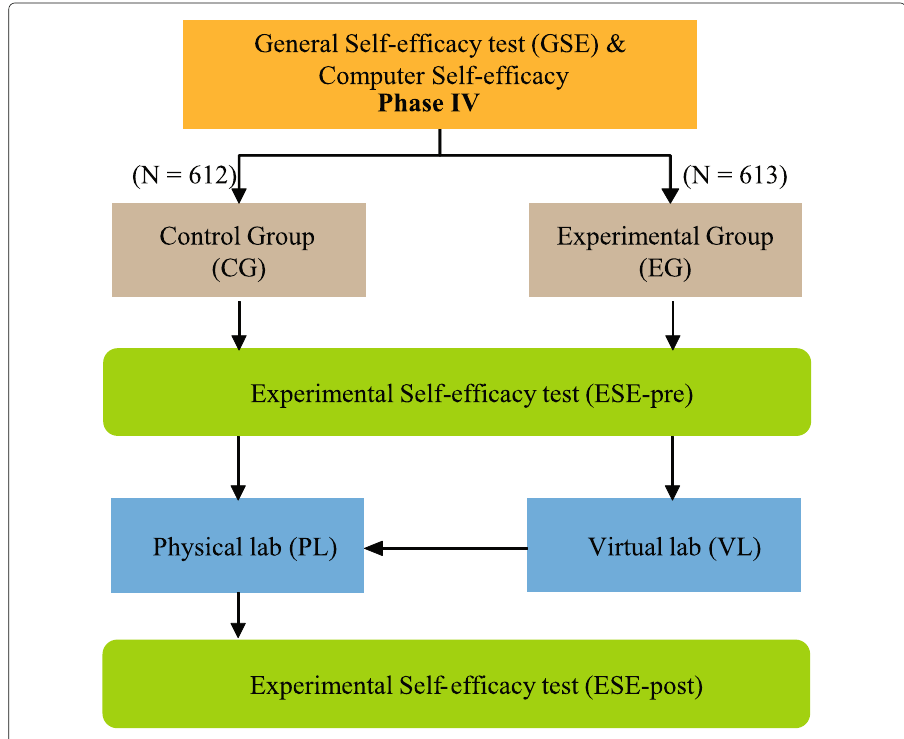
Fig. 4 Study design for the characterization of experimental self-efficacy of students